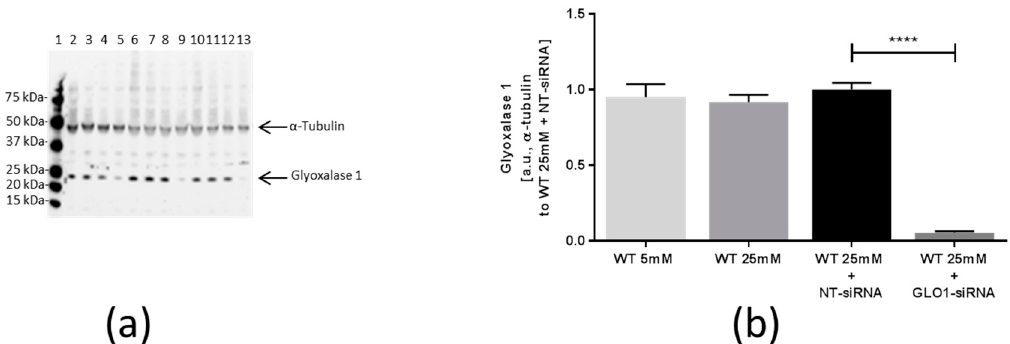
Figure 1. Analysis of glyoxalase 1 (GLO1) expression. ( a ) Western Blot analysis for GLO1 protein of L6 myoblasts transfected with non-target siRNA and GLO1 specific siRNA following 48 h siRNA transfection. Lane 1: Precision Plus Protein Standard; lane 2, 6, 10: WT 5 mM; lane 3, 7, 11: WT 25 mM, lane 4, 8, 12: WT 25 mM + non-target siRNA (NT-siRNA); lane 5, 9, 13: WT 25 mM + GLO1-siRNA. ( b ) Graphical analysis of Western Blot. Data are mean ± SEM ( N = 3, n = 3). Significance: **** p < 0.0001, WT 25 mM + GLO-siRNA vs. WT 25 mM + NT-siRNA.